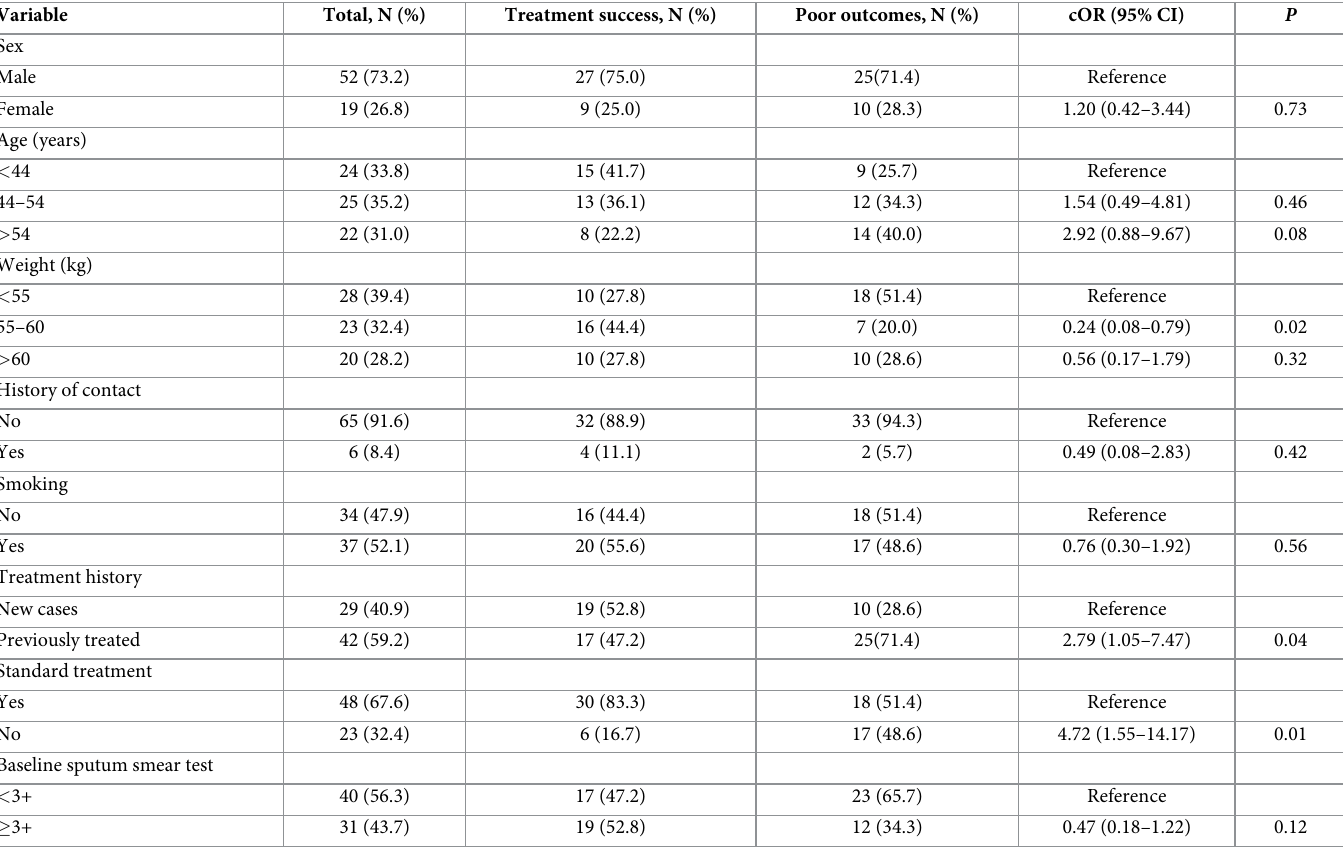
Table 3. Univariable logistic regression analysis of demographic factors associated with treatment